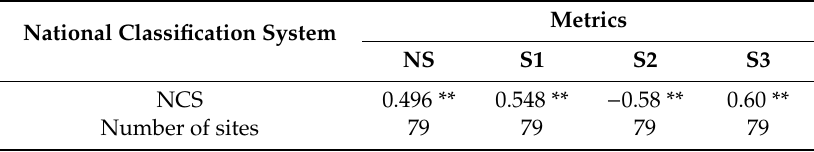
11 of 18 Table 6. Comparison of primary and audited classifications. Underevaluation occurs when primary classification is lower than the audited classification, with the opposite for overevaluation. When both classifications match, it is considered as correct. Underevaluations 0 3.3. Accuracies of Simple New Tolerance Metrics Compared to the NCS All metric classifications are significantly correlated ( p < 0.01) with the NCS classification (Table 7). However, a more detailed analysis, based on the incorrect classifications for five and for two